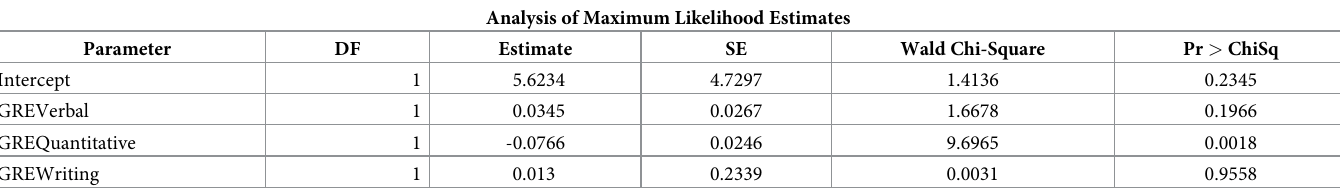
Table 2. Maximum likelihood estimates for dropout from chemistry programs (N =